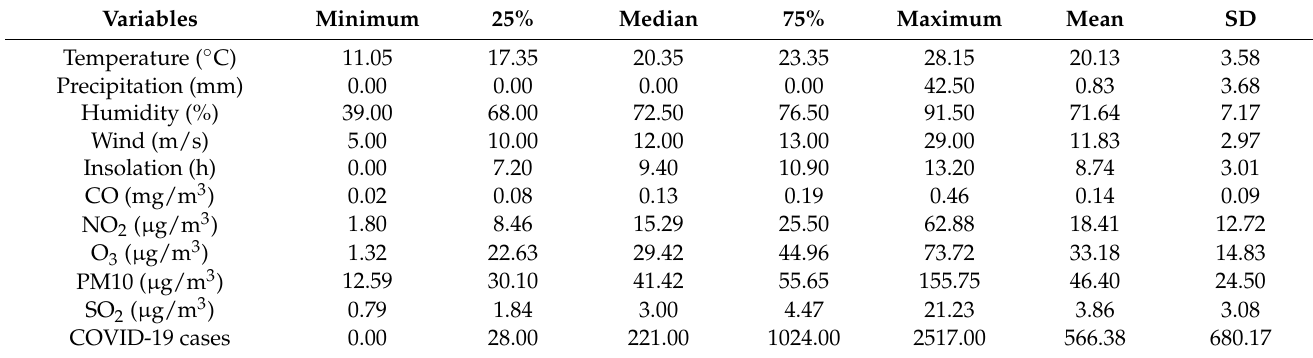
Table 1. Descriptive statistics for meteorological parameters, air quality parameters and